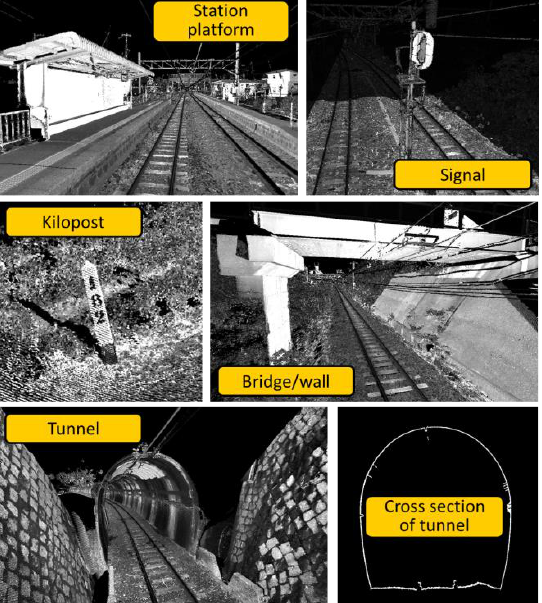
Figure 7. An example of the obtained point cloud by